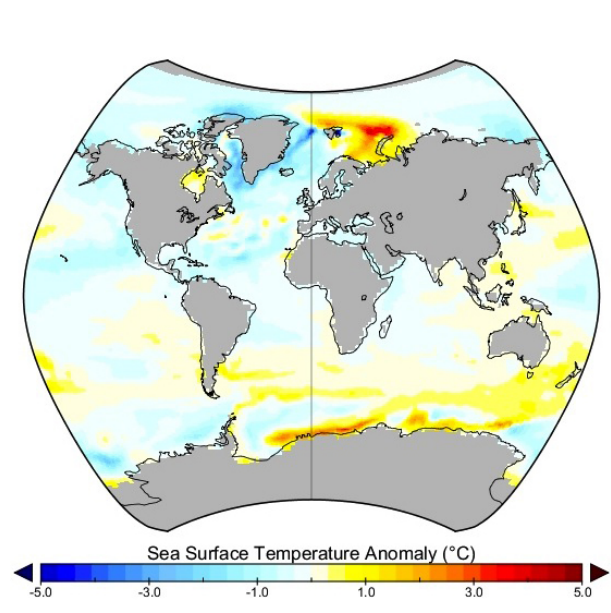
Figure 9. Difference in sea surface temperature between Exp. 3a and 3b in the last of 350 years of model